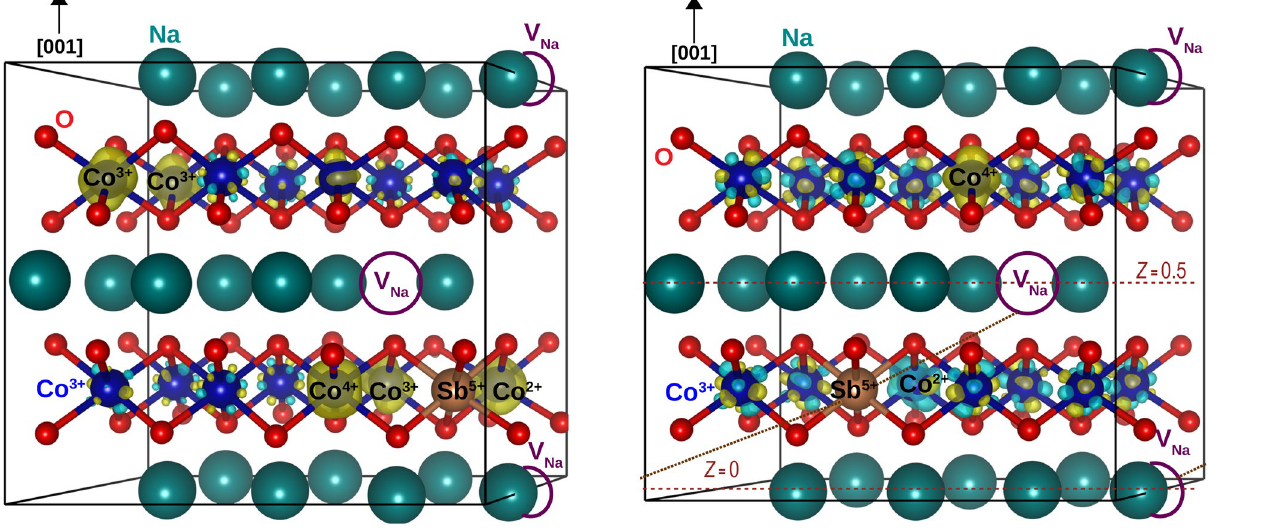
Fig. 3 The spin density of the 2 a × 4 a × 1 c supercell used for simu- lating Na 0.875 CoO 2 :Sb Co compound. Here, Sb 5+ is at the closest dis- tance to the V Na s as in Fig. 1, however, the spin state of Co ions cor- responds to an excited state